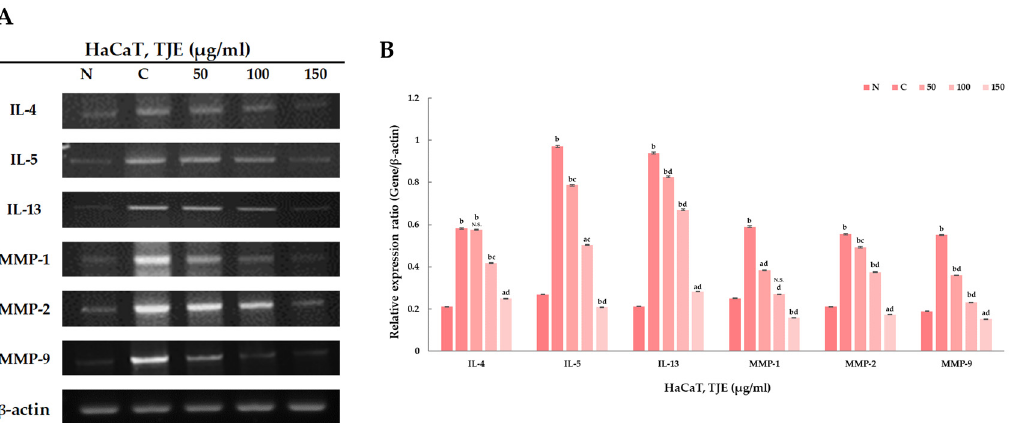
Figure 5. ( A , B ) The levels of IL-4, -5, -13 gene and MMP-1, -2, -9 gene were determined by RT-PCR. The β -actin probe served as protein-loading control. The statistical analysis of the data was carried out by use of a t-test. a p < 0.01 and b p < 0.001 vs. con (N). c p < 0.01 and d p < 0.001 vs. con (C) (each experiment, n = 3). N.S.: not significant. N: negative control, C: positive control (only TNF- α (10 ng/mL) and IFN- γ (10 ng/mL) treated group).